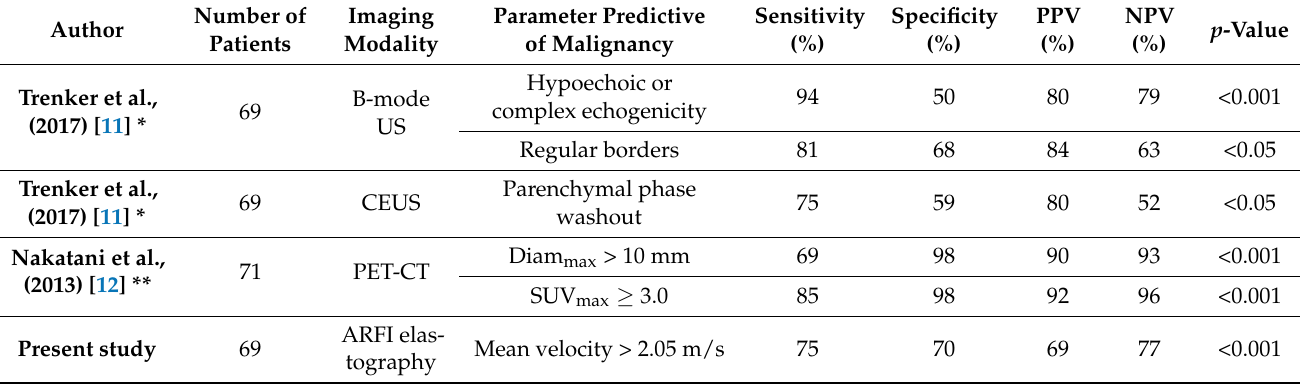
Table 3. Comparison of various imaging modalities regarding their diagnostic performance in differentiating benign and malignant mesenteric